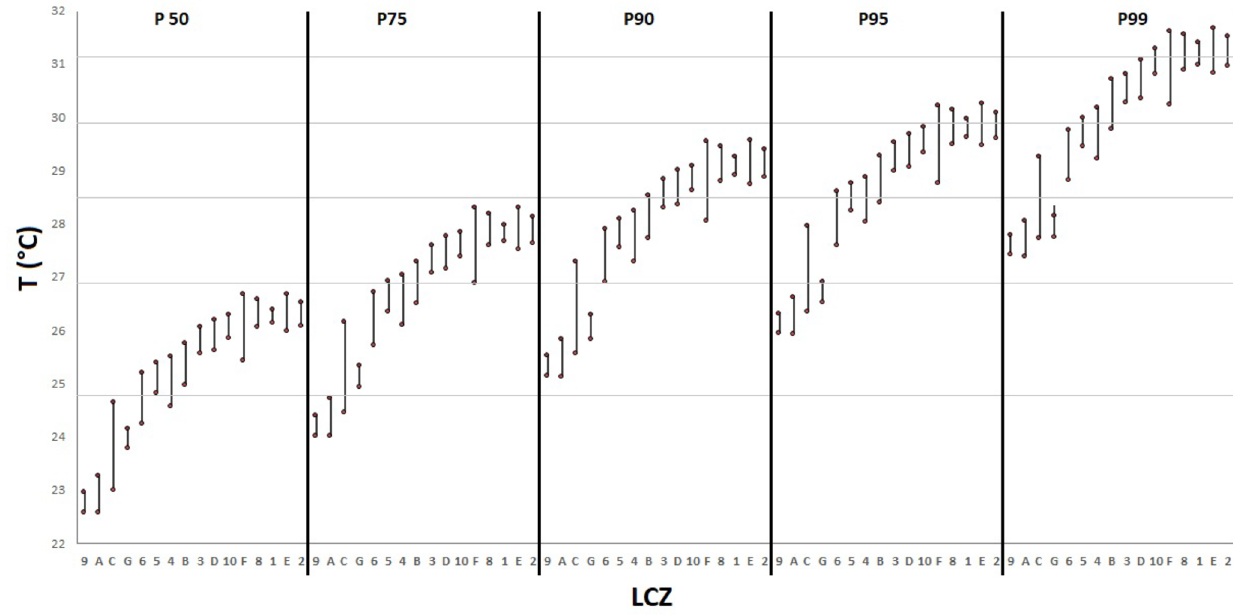
Figure 10. Characterisation of every LCZ with the daily mean temperature (1987–2016) for each probability scenario. Each bar shows P25 and P75, around the median for each LCZ (ordered from lowest to highest temperature). The horizontal grey lines are the different HEI scenarios (2 to 7, low to high).